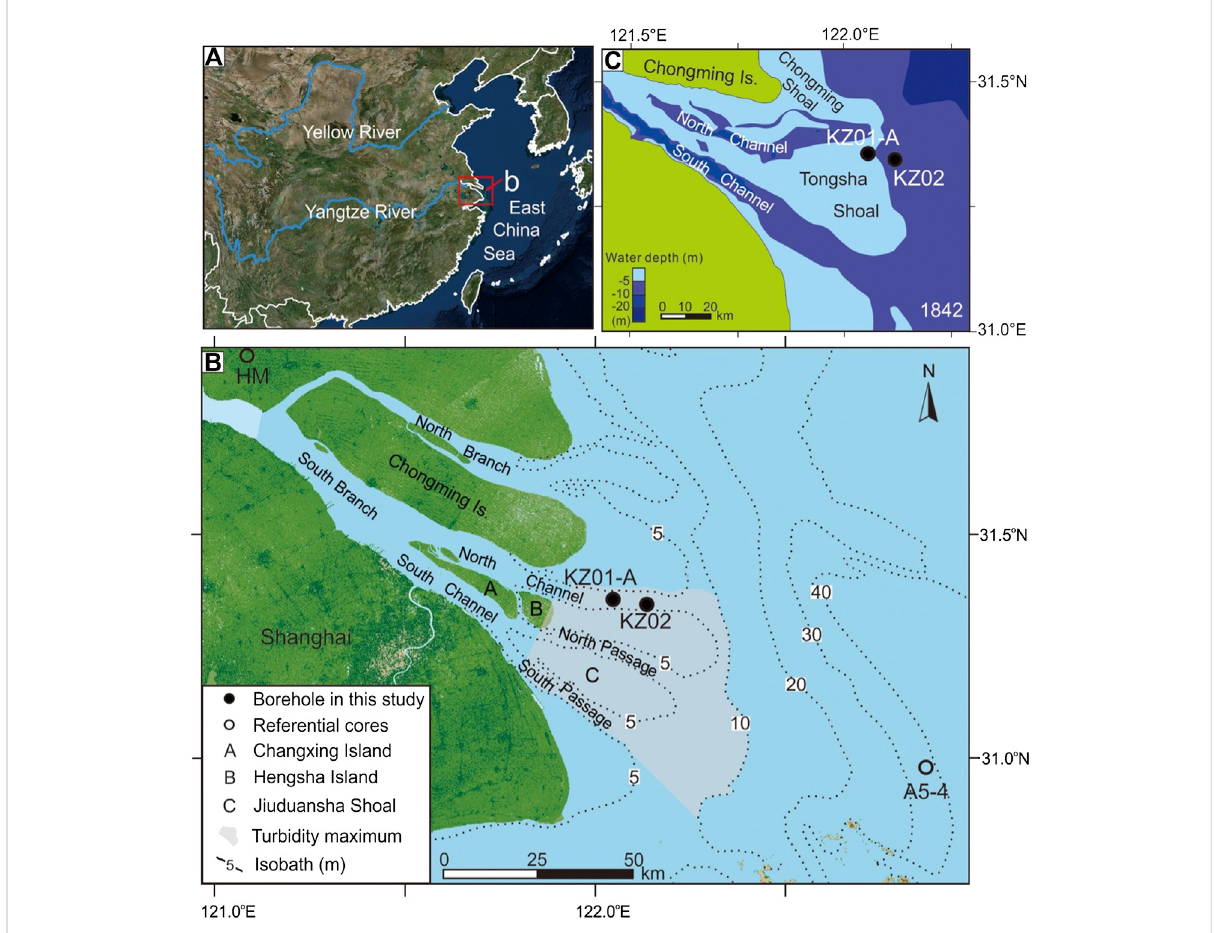
FIGURE 1 Location maps. (A) Yangtze River mouth (after Niu et al., 2021). (B) Locations of cores KZ01-A and KZ02 in the present-day North Channel and the turbidity maximum zone (TMZ; after Shen and Pan, 2001). (C) Bathymetry of the Yangtze River mouth in 1842 CE, showing the location of